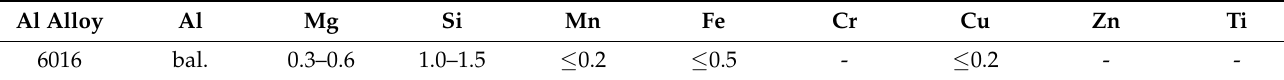
Table 1. Nominal chemical composition, % vol., of the 6016 aluminum